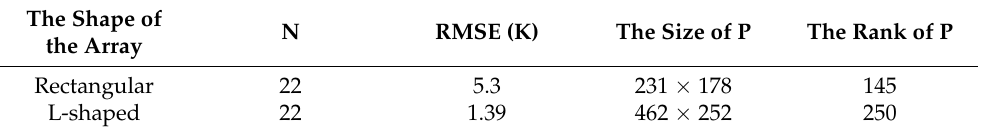
Table 6. Parameter comparison of the